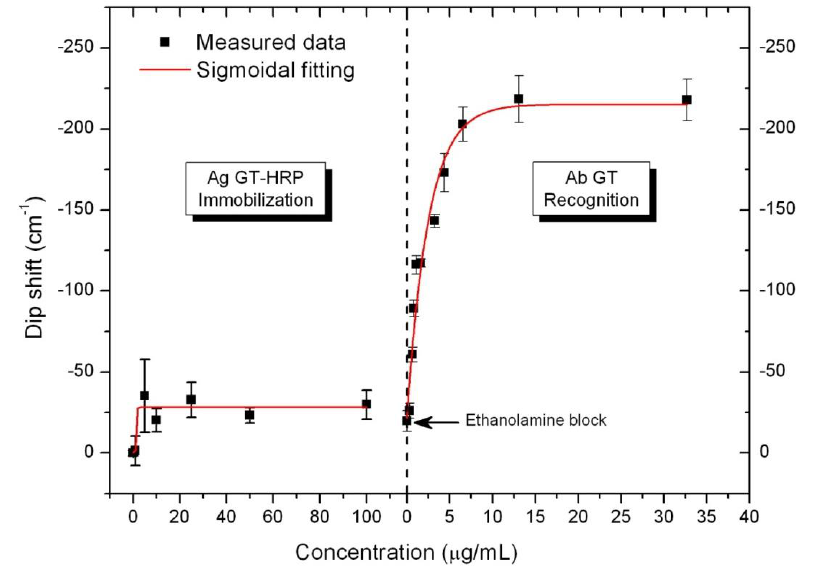
Figure 5. Dip shift for HRP-h-G immobilization and anti-gestrinone antibody recognition for the dip centered at 15,300 cm −1 . Each measurement is the average of five